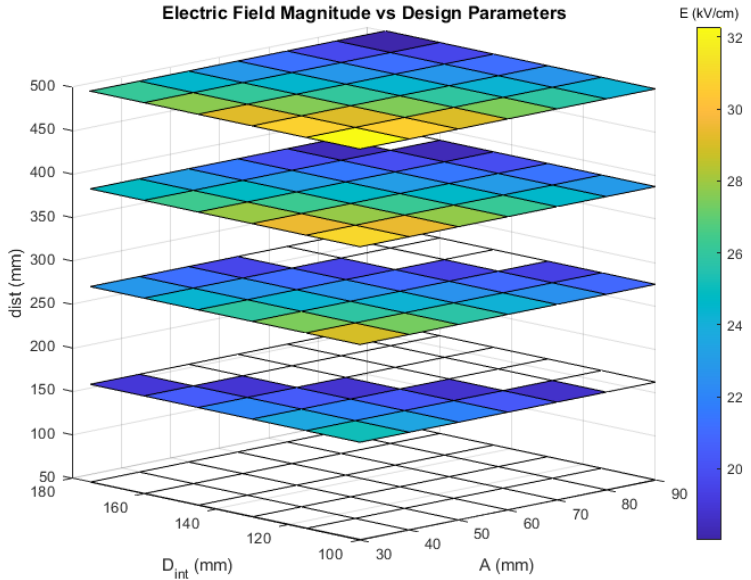
Figure 7. Electric field on connector 1 as a function of the ring dimensions: thickness (A), internal diameter (Dint), and ring–connector distance (dist), represented simultaneously.